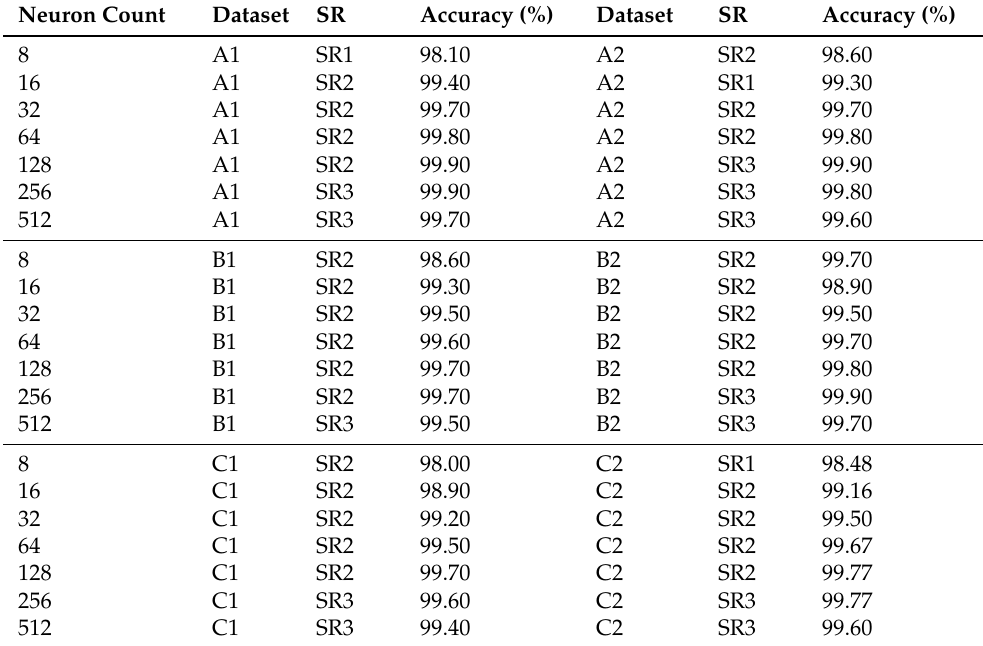
Table 4. Cross-validation accuracy of the developed model.